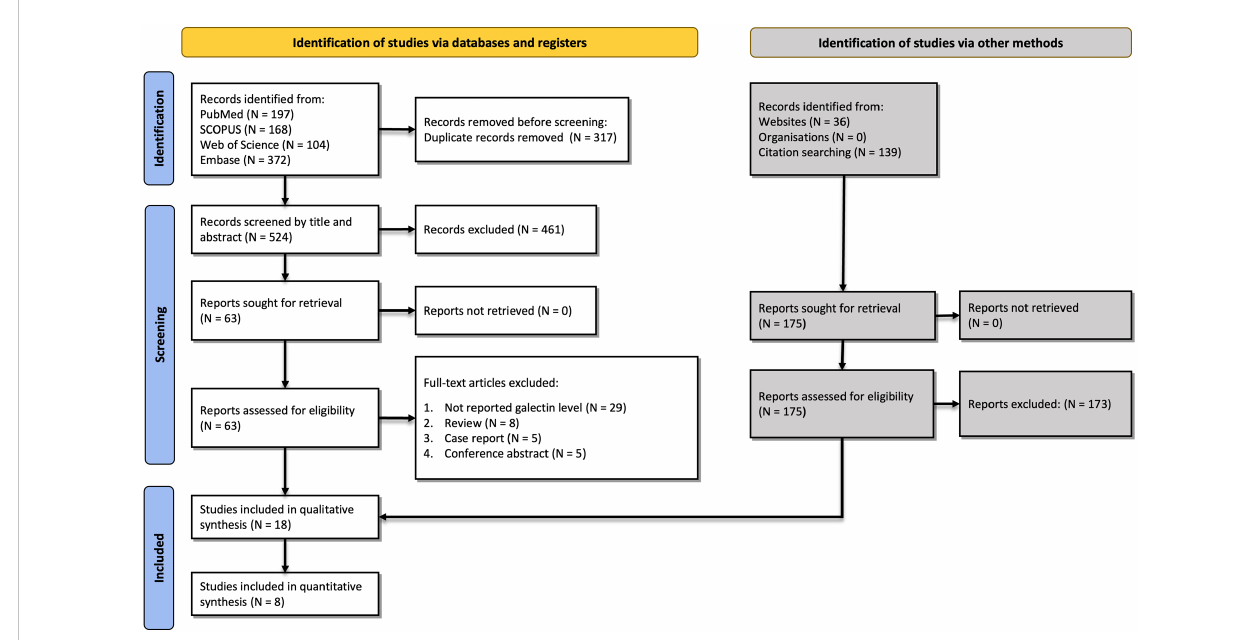
FIGURE 1 Flow diagram summarizing the selection of eligible studies based on the PRISMA